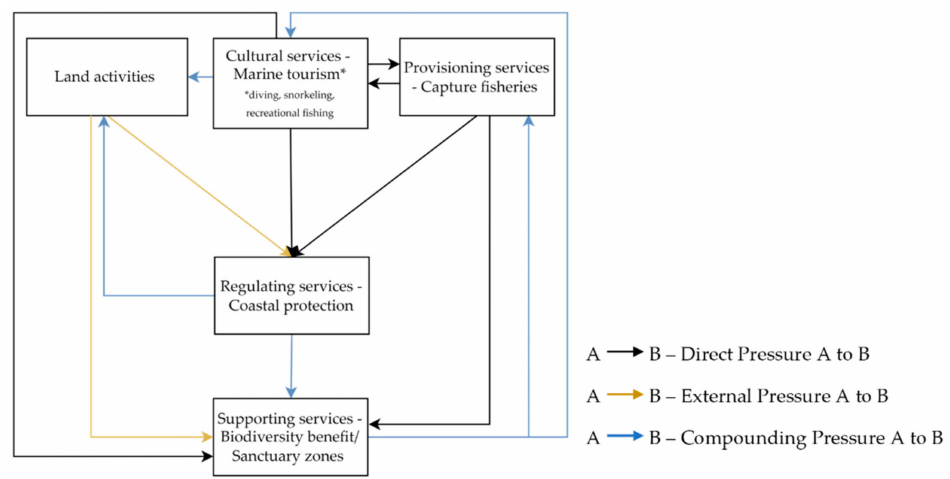
Figure 6. Conceptual diagram of the interaction of ecosystem services in the GMMTP coral reef